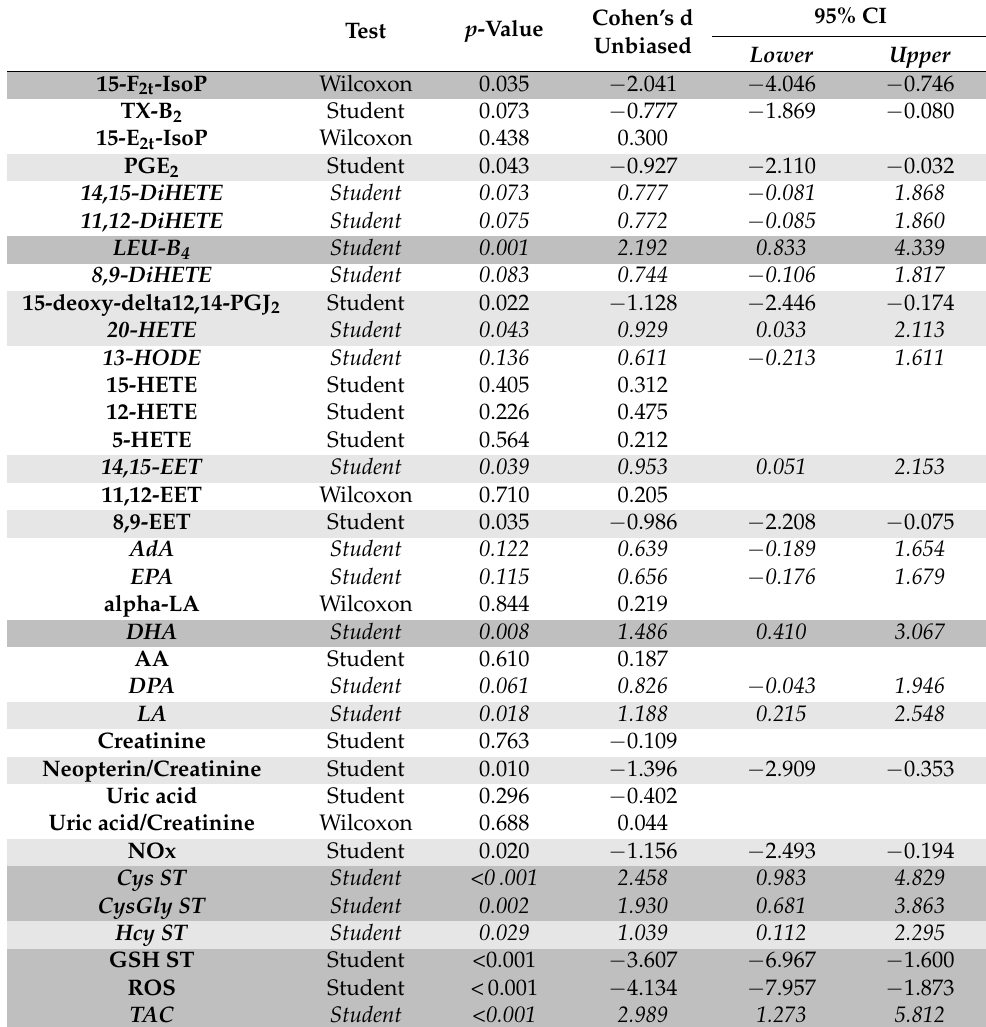
Table 1. Statistical